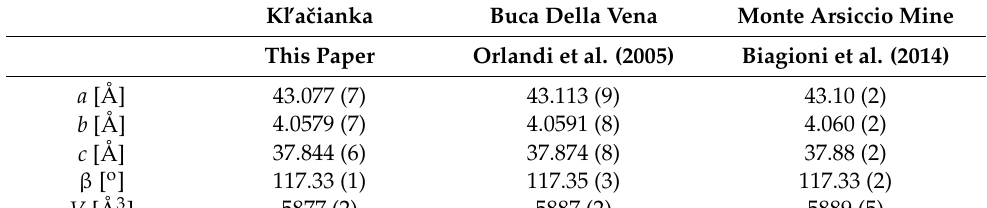
Table 3. Unit-cell parameters of rouxelite (for monoclinic space group C 2/ m ). Buca Della Vena Kľačianka